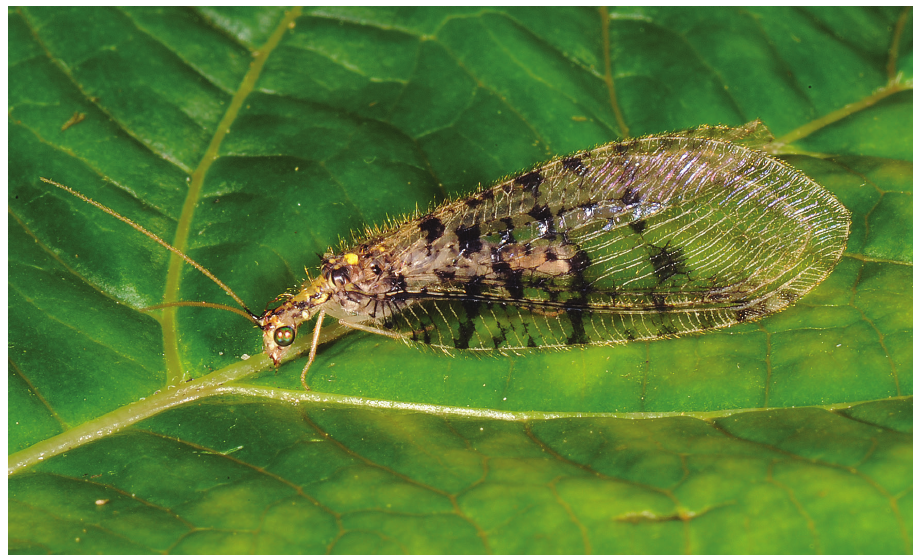
Figure 1. Gryposmylus pubicosta (Walker), male (dark form) Sabah, Malaysia (photograph credit: Stephen D.